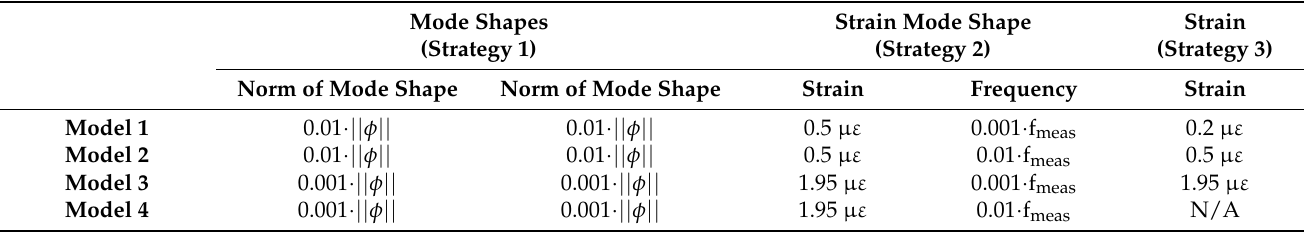
Figure 12. Influence of the measurement error on the uncertainty of the posterior cost. The error bar represents one time the standard deviation of the costs (for the strategies, reference is made to Table 2). Table 8. Different assumed models for the measurement